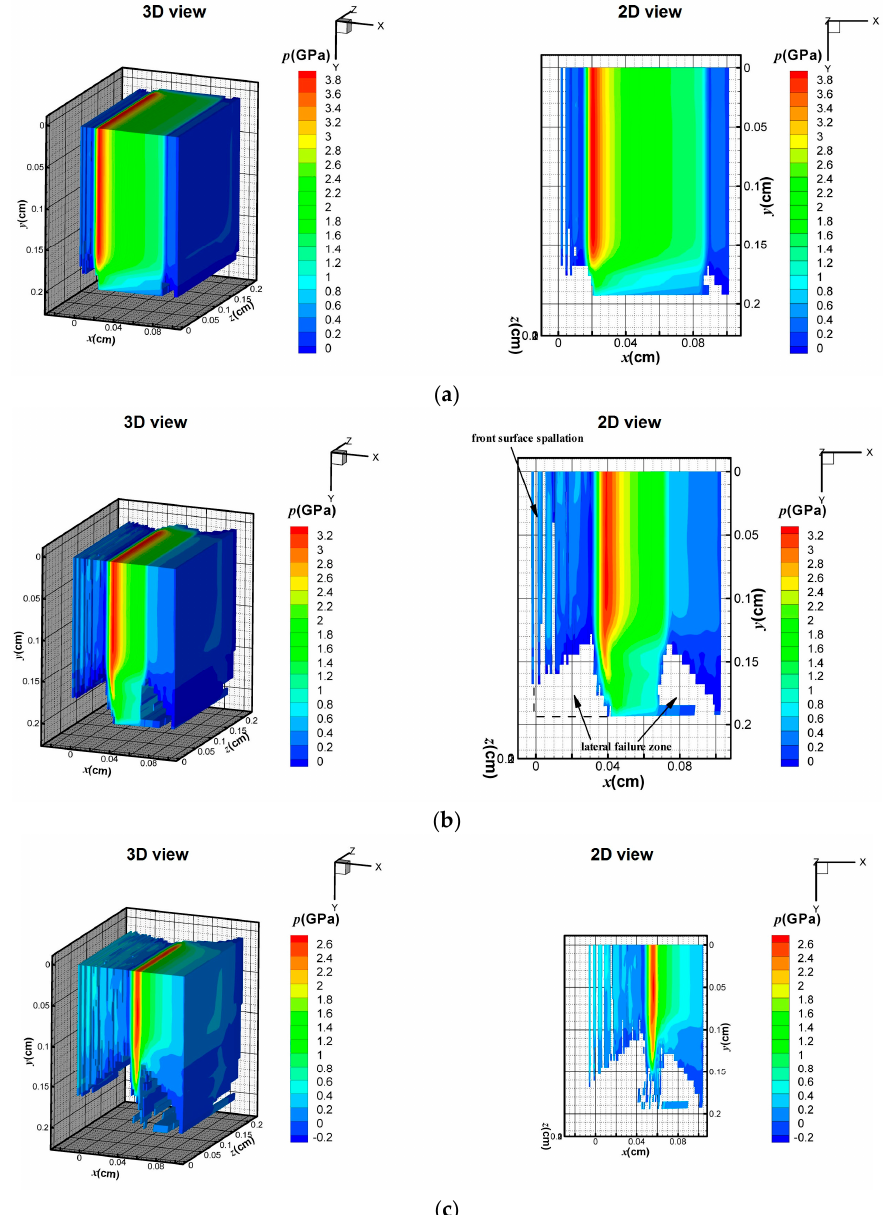
Figure 8. Stress wave under 3 keV X-ray at: ( a ) 0.05 μ s; ( b ) 0.10 μ s; and ( c ) 0.15 μ s.